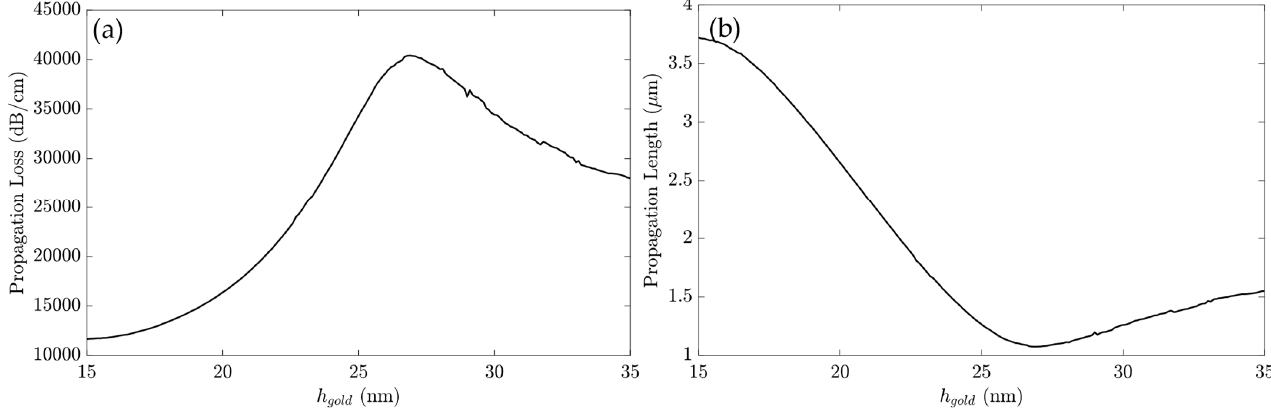
Figure 6. The gold layer above the waveguide. ( a ) α versus h Au and ( b ) PL versus h Au